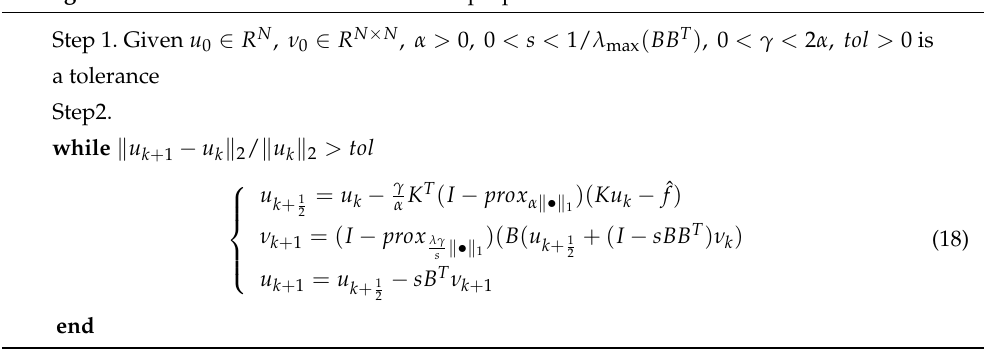
Algorithm 1 The numerical scheme for the proposed